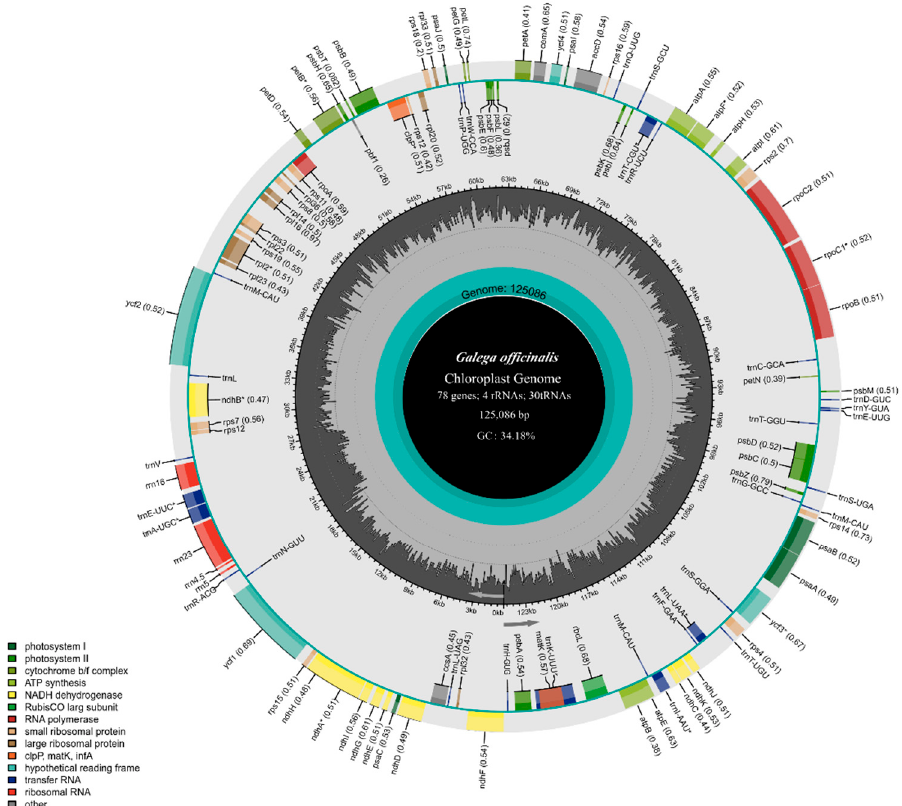
Figure 2. The chloroplast genome map of Galega officinalis . The genes drawn inside and outside of the circle are transcribed counterclockwise and clockwise, respectively. The dark gray inside the circle represents GC content, and the light gray corresponds to AT content. * Genes with introns. Table 1. Lengths of introns and exons of the split genes in the Galega orientalis complete chloro- plast genome.